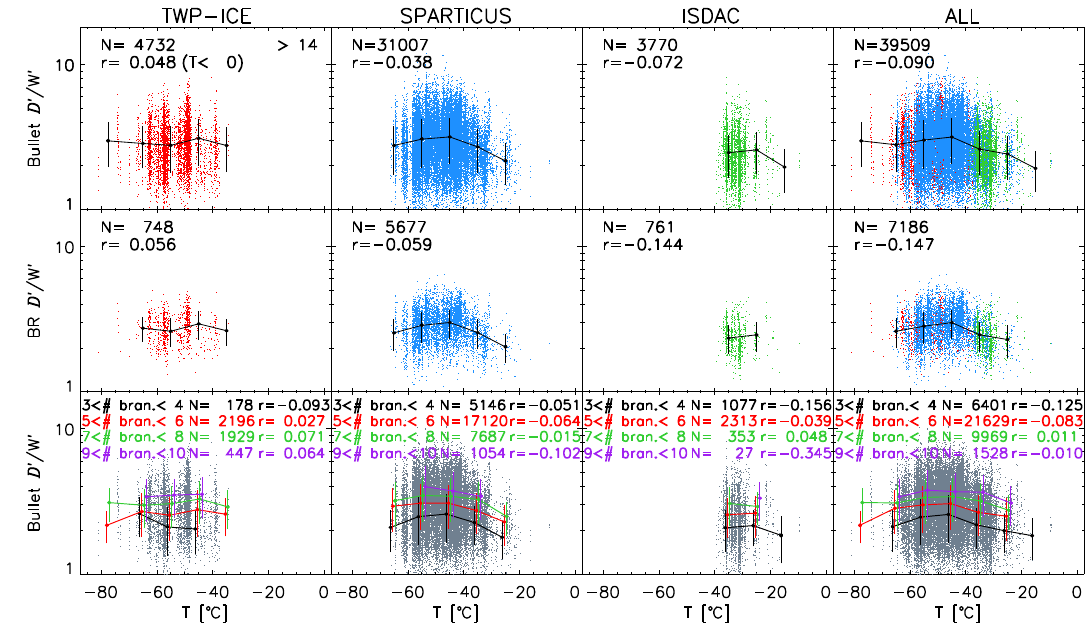
Figure 14. The projected aspect ratio ( D (cid:48) /W (cid:48) ) of bullets (top row) and bullet rosettes (middle row) as a function of temperature, whereas the bottom row shows the dependence of D (cid:48) /W (cid:48) of individual bullets on the number of branches in a bullet rosette. The data in the bottom row are gridded by temperature and offset for